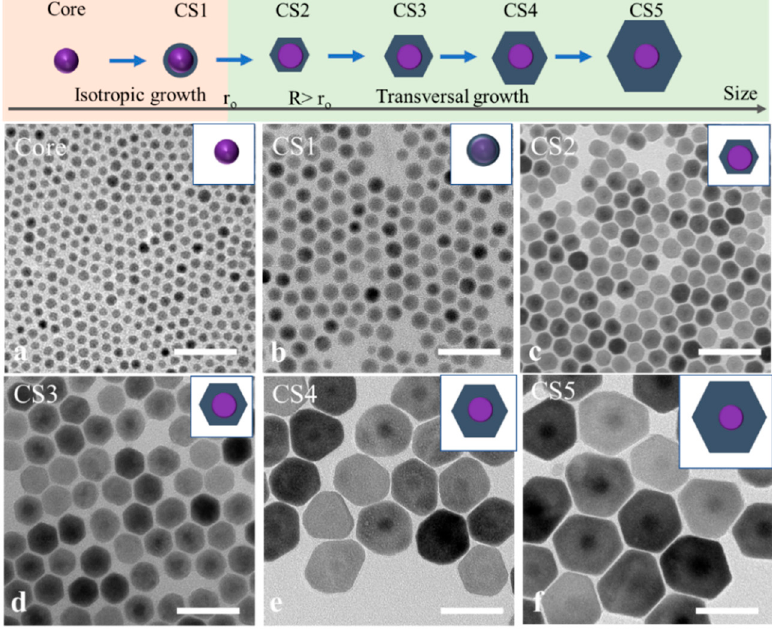
Figure 3. TEM images of core-only NaGdF 4 :Yb 3+ , Tm 3+ nanoparticles (NPs) ( a ) and NaGdF 4 :Yb, Tm@NaYF 4 core–shell NPs with different amounts of shell precursors (( a ) 1 mL, ( b ) 2 mL, ( c ) 4 mL, ( d ) 8 mL, ( e ) 16 mL, ( f ) 32 mL). The 2D shell growth process with increasing precursor injection under 280 °C, scale bar 50 nm.